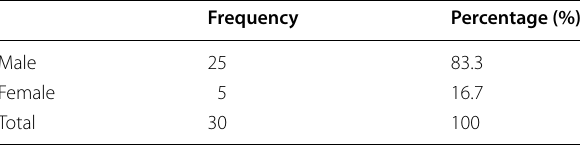
Table 1 MRI protocol at our institution for assessing perianal inflammatory disorders Process and position TR